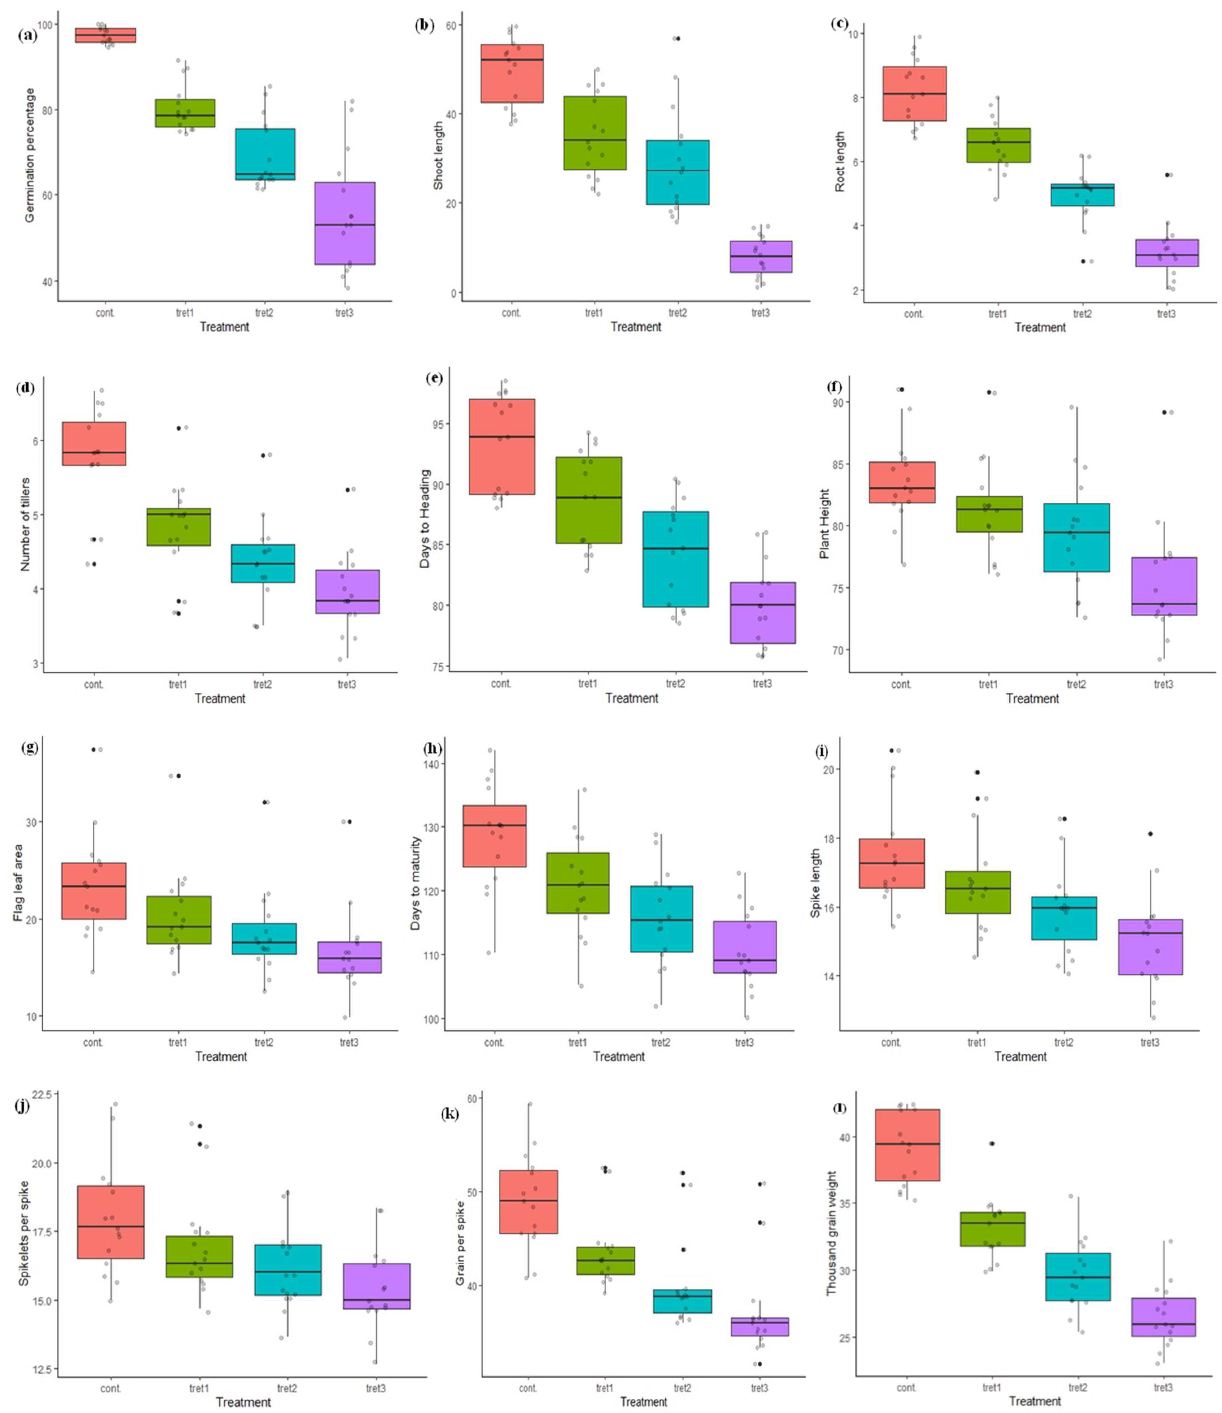
Figure 1. Variation in morphological traits in control (0%PEG), 5% PEG, 10% PEG and 15% PEG treatment condition: ( a ) germination percentage, ( b ) shoot length, ( c ) root length, ( d ) no. of tillers, ( e ) days to heading, ( f ) plant height, ( g ) flag leaf area, ( h ) days to maturity, ( i ) spike length, ( j ) spikelets per spike, ( k ) grain per spike, ( l ) thousand grain weight.